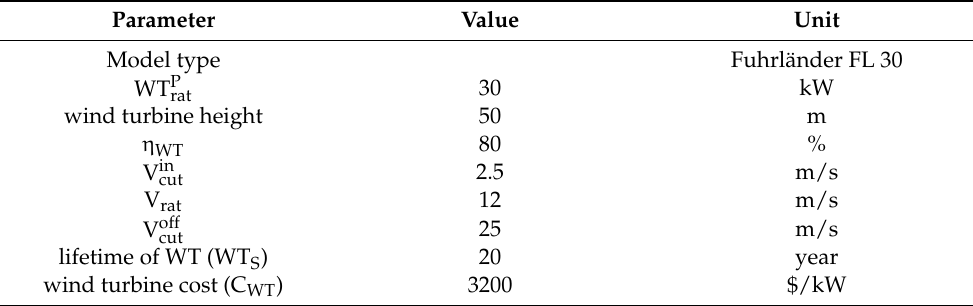
Table 2. The main parameters of the selected wind turbine model [30]. Parameter